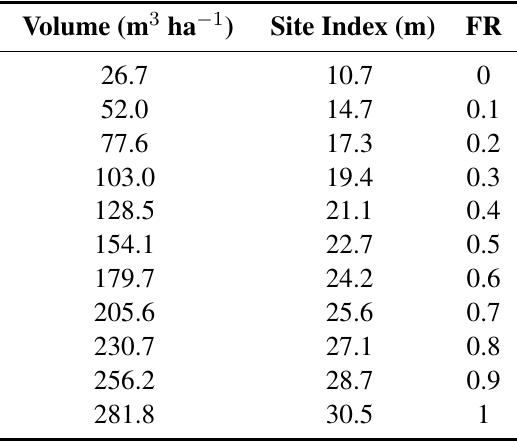
Table 5. Value of volume (m 3 ha − 1 ) that corresponded to the value of FR based on the assumed linear incremental relationship and the respective value of site index (m) based on the sigmoidal relationship between stand volume and site